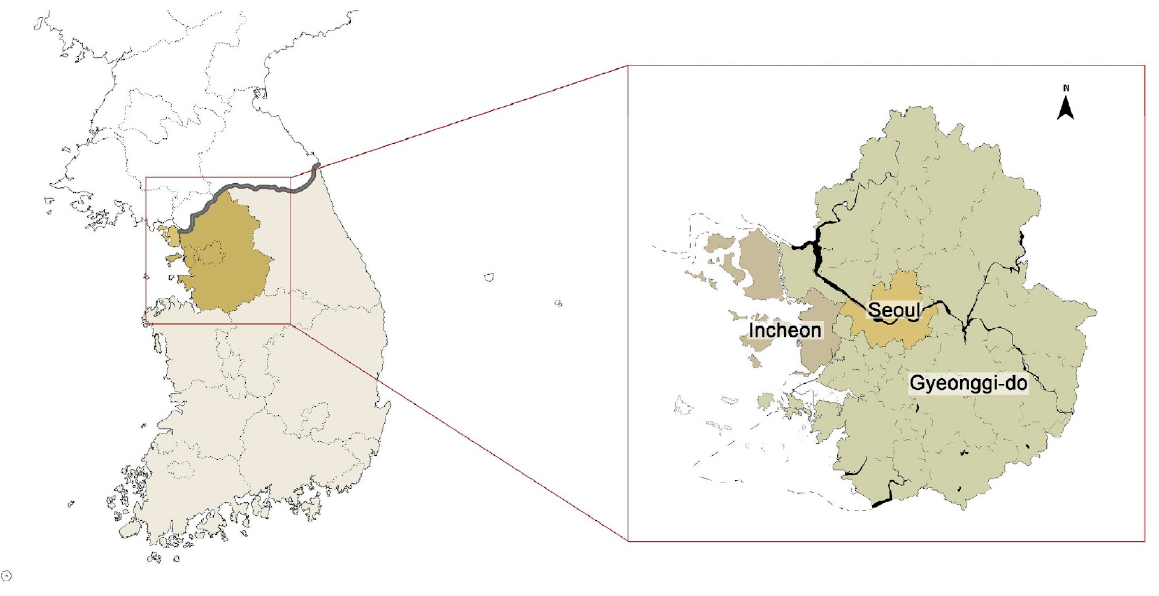
Figure 1. Location of the study area.